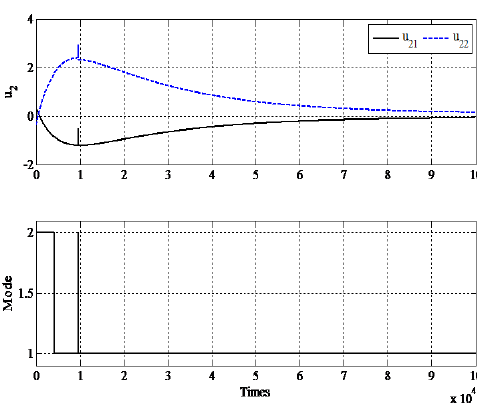
Fig. 4: Control signal and switched laws’ evolutions of the second